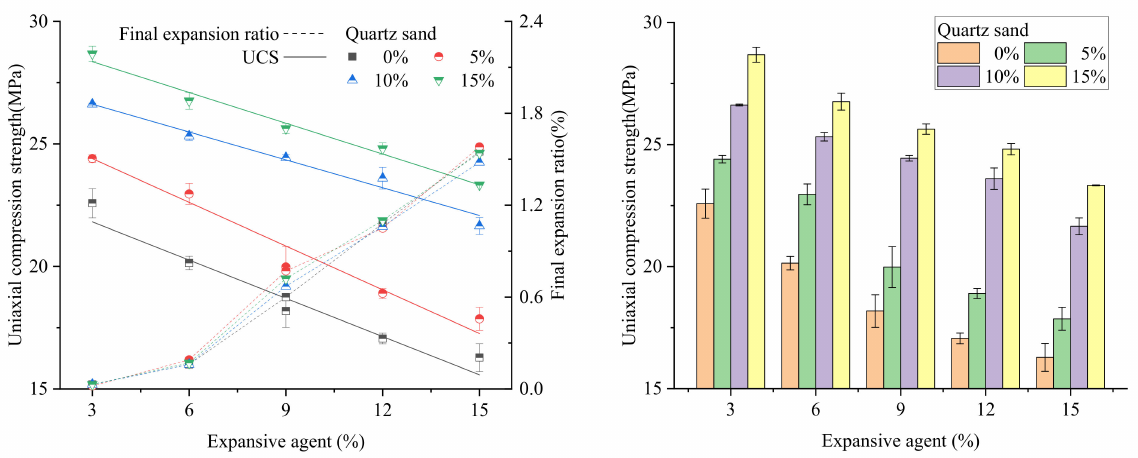
Figure 6. The UCS of expansive grout